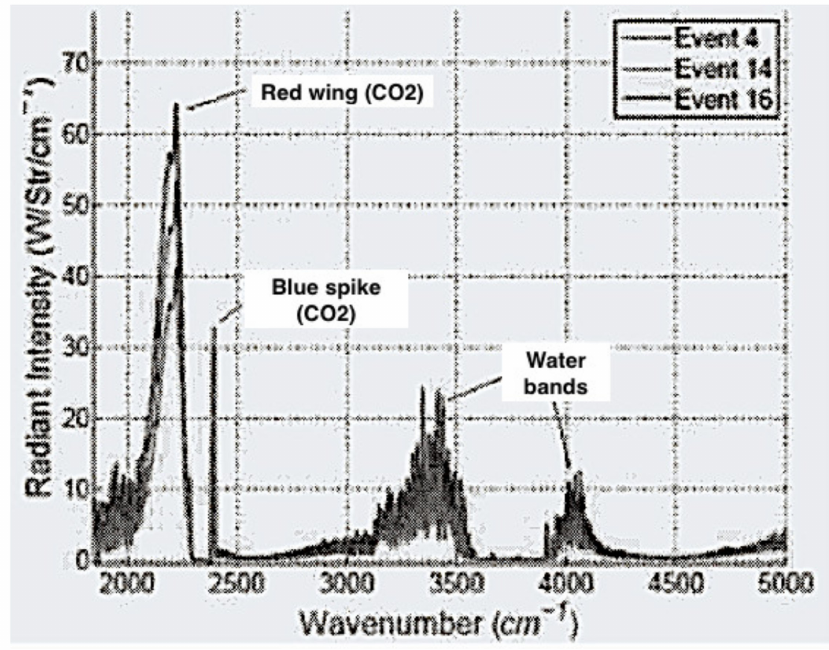
Figure 4. Plume spectral intensity in the 2000–5000 cm − 1 range (from [15]).